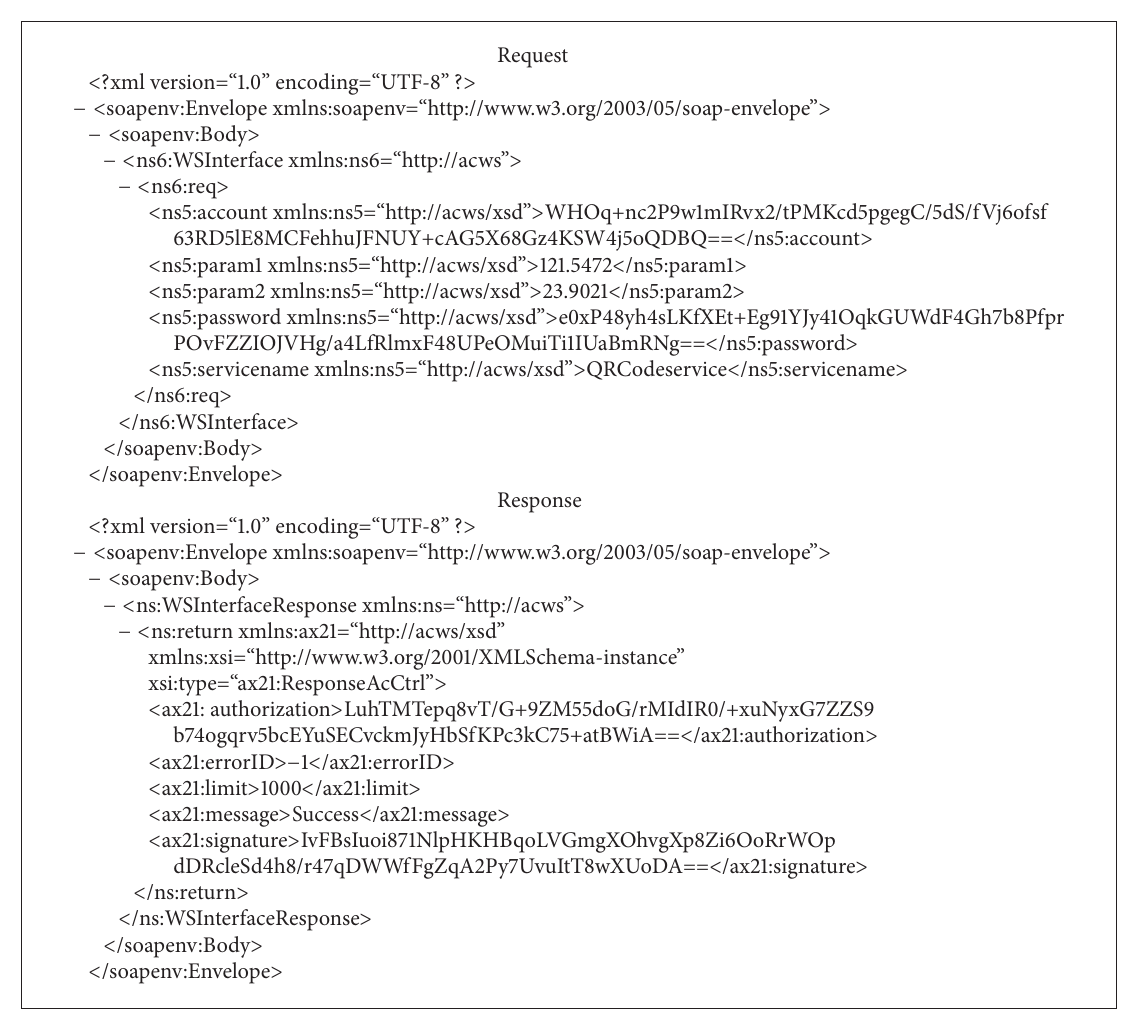
Algorithm 2: The request and response SOAP messages.